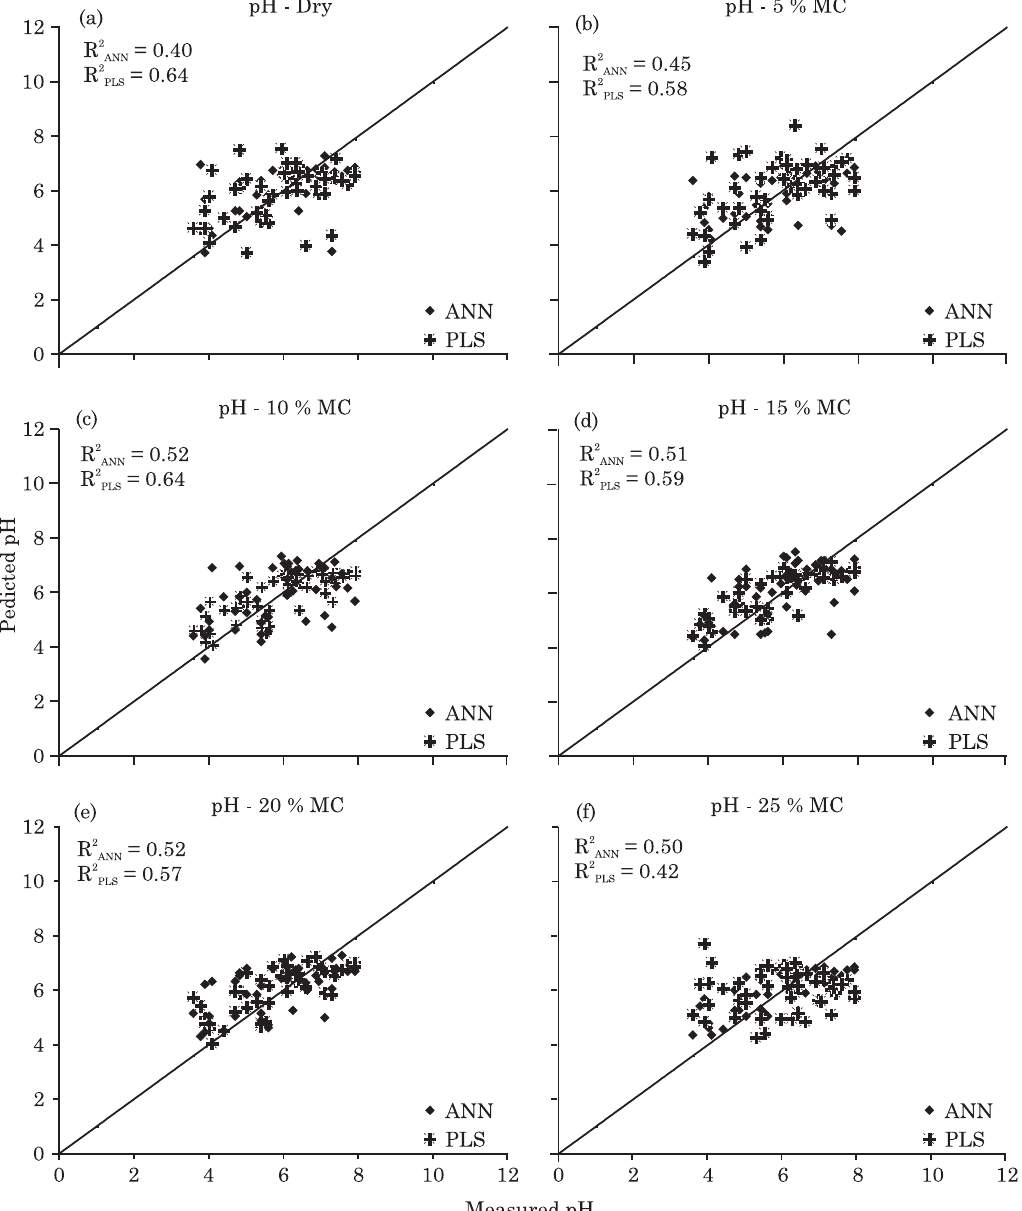
Figure 4. Effect of moisture content (MC) and calibration technique on R 2 of pH prediction with partial least squares (PLS) and the artificial neural network